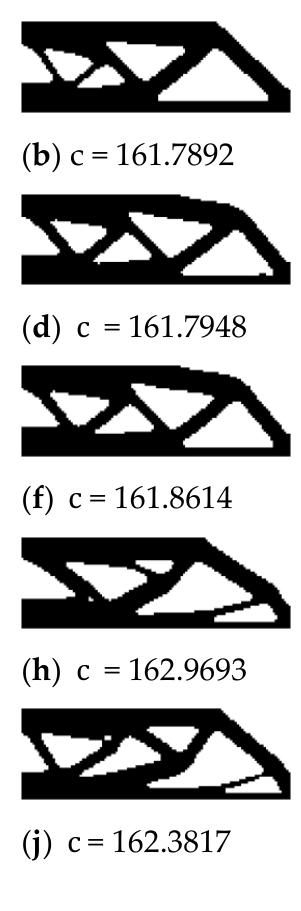
Figure 5. Final results from 10 runs of the MBB beam. It can be seen from the optimization results that the randomness of the genetic algo- rithm means there is some variation in the results of each operation. Nevertheless, the average results obtained by the SIMP-GA method are better than those obtained by the SIMP method (Table